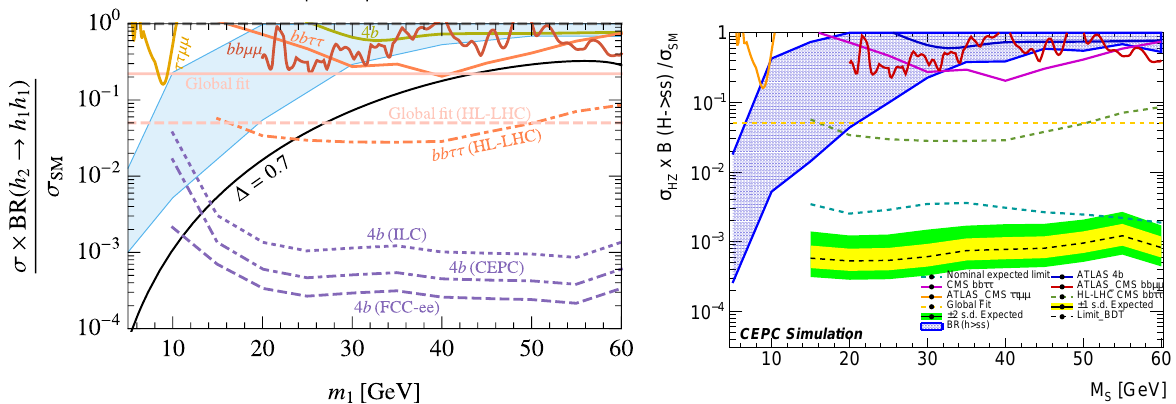
Figure 15. Expected bounds on Higgs production via Higgs–Strahlung and subsequent decay into two light scalars, in the singlet extension scenario discussed in [49,50]. Left : Taken from [49]. Right : Results presented in [50], for CEPC at 250 GeV. The blue band denotes the region where a strong first-order electroweak phase transition is possible. We see that e + e − Higgs factories are required on order to confirm or exclude such scenarios. LHC searches as well as projections stem from